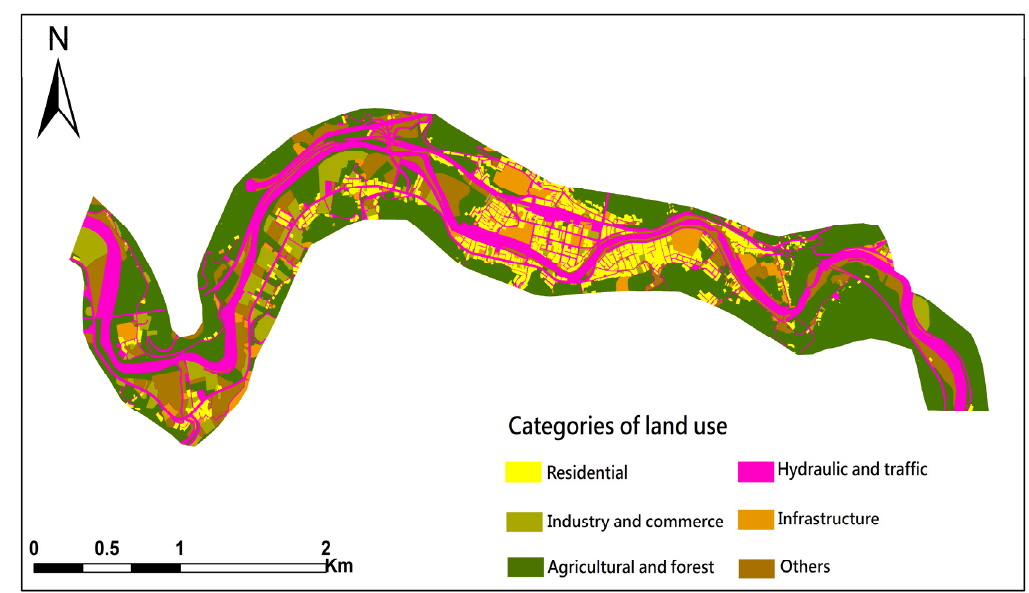
Figure 10. Land use in the model